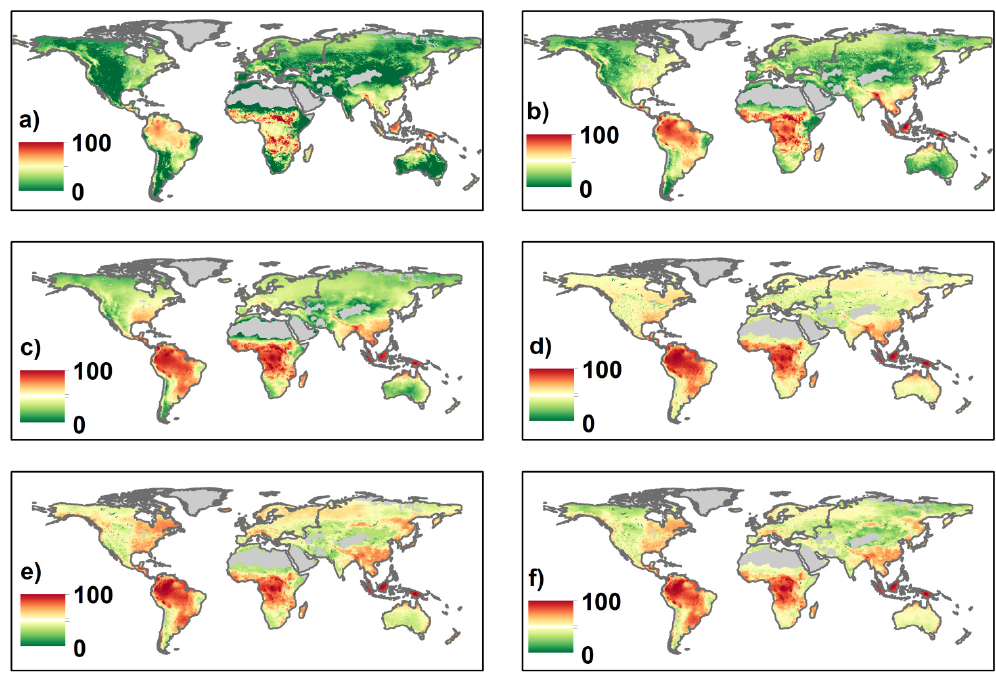
Figure 4. Map of the stepwise sensitivity analysis as provided by additive aggregation. ( a ) AB + SR; ( b ) AB + SR + NI; ( c ) AB + SR + NI + AET; ( d ) AB + SR + NI + AET + AI; ( e ) AB + SR + NI + AET +